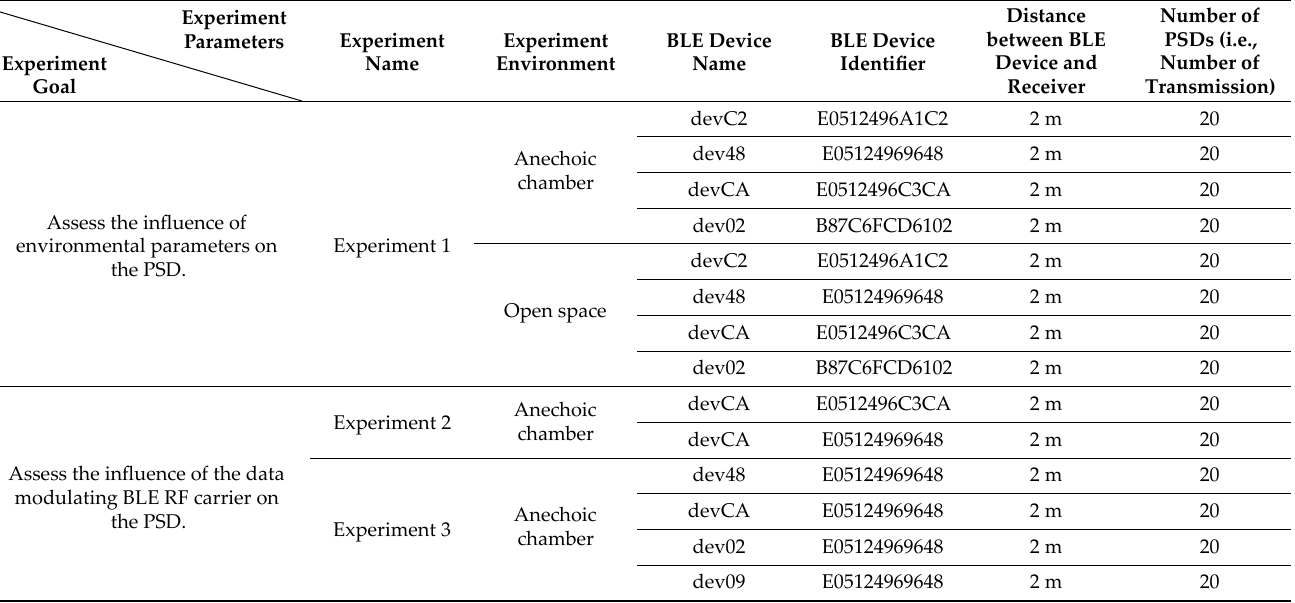
Table 1. Summary of the experiments in this